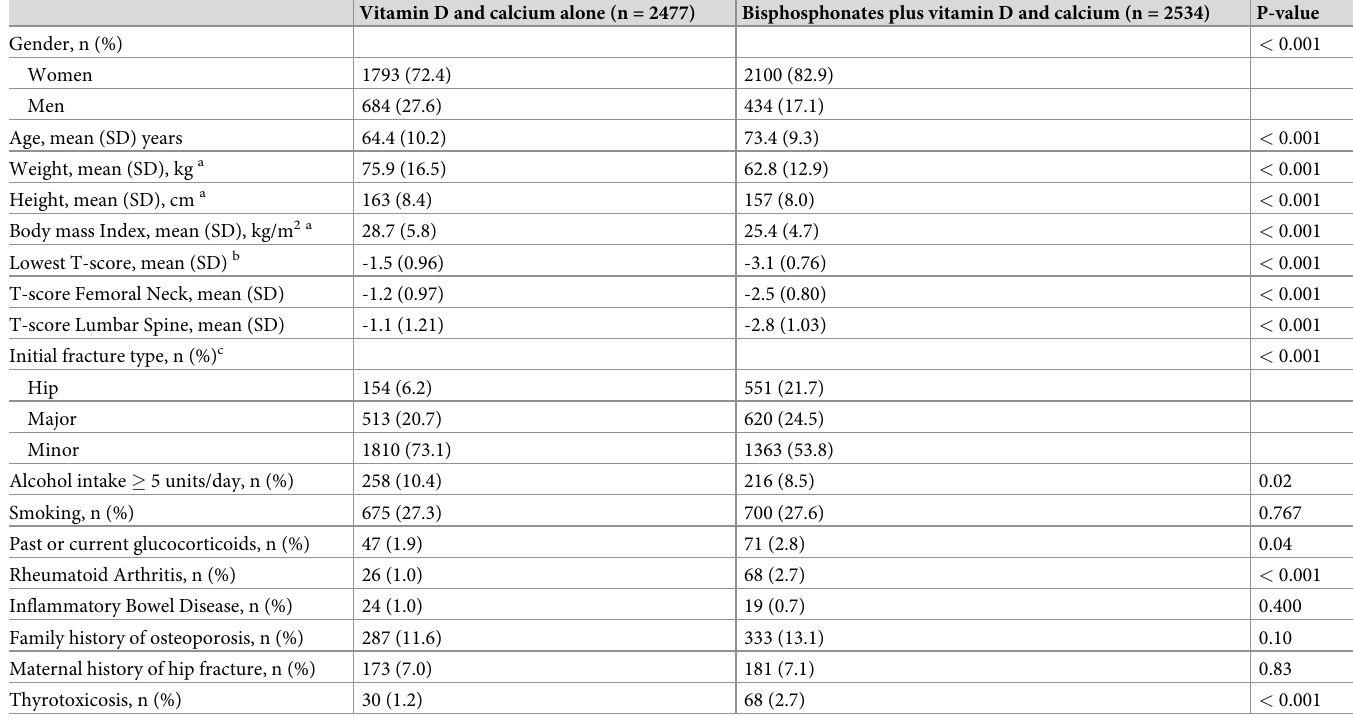
Table 1. Characteristics of patients prescribed oral bisphosphonates compared with those prescribed only calcium and vitamin D. Vitamin D and calcium alone (n = 2477) Bisphosphonates plus vitamin D and calcium (n = 2534) P-value